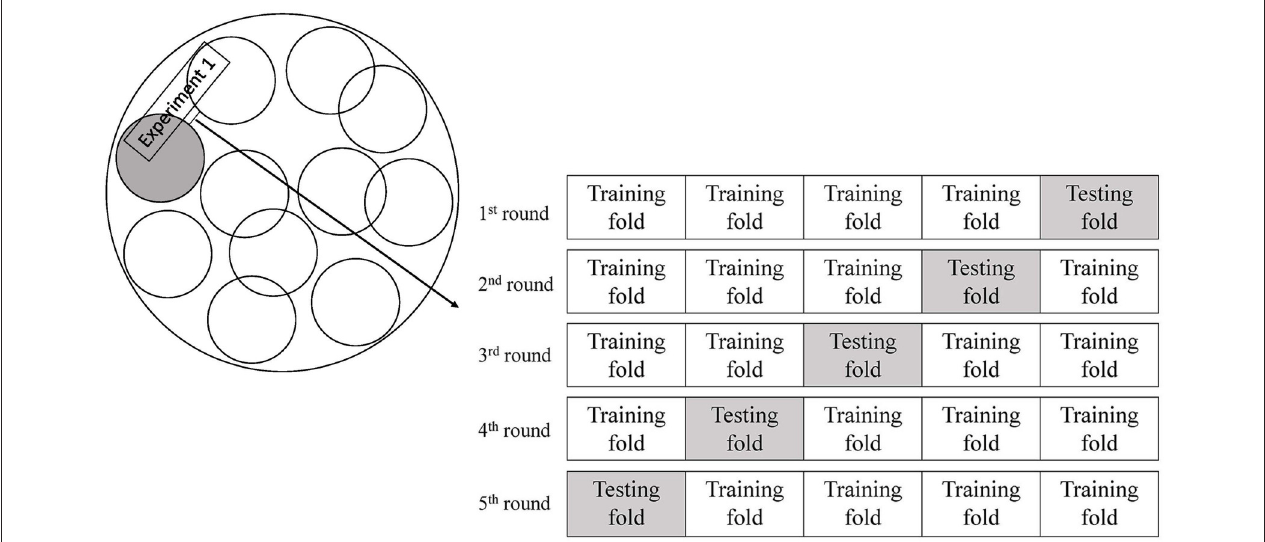
− 1 and + 1 for the independent variables to speed up the learning process and escape local minima. We obtained the sensitivity, specificity, accuracy, and the c statistic of the ANN models developed in each of the 5 rounds of training and testing, in each of the 10 cross-validation experiments; we then computed the overall medians (interquartile range, IQR) of sensitivity, specificity, accuracy and c statistic of the models in all of the 50 rounds of training and